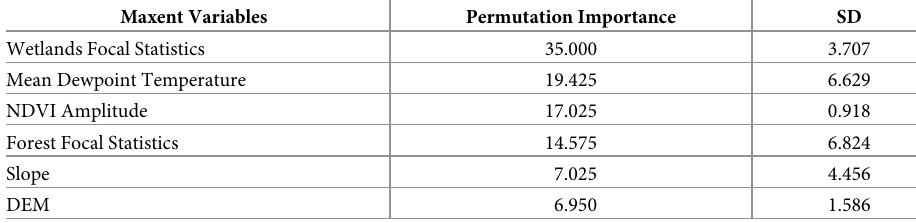
Table 3. Maximum entropy variable permutation